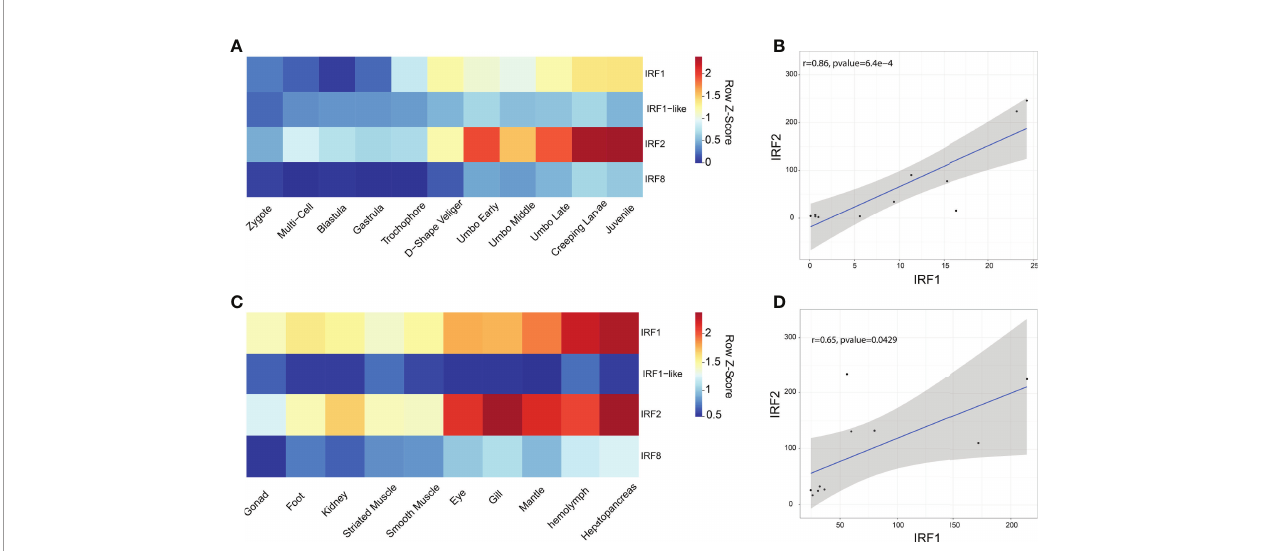
FIGURE 4 | Expression pro fi les of CfIRFs in different developmental stages and adult tissues. (A) Heatmap of CfIRFs expression pro fi le in different embryonic and larval stages. (B) The positive correlation between CfIRF1 and CfIRF2 in different developmental stages. (C) Expression pro fi les of CfIRFs in adult tissues. (D) The positive correlation between CfIRF1 and CfIRF2 in adult